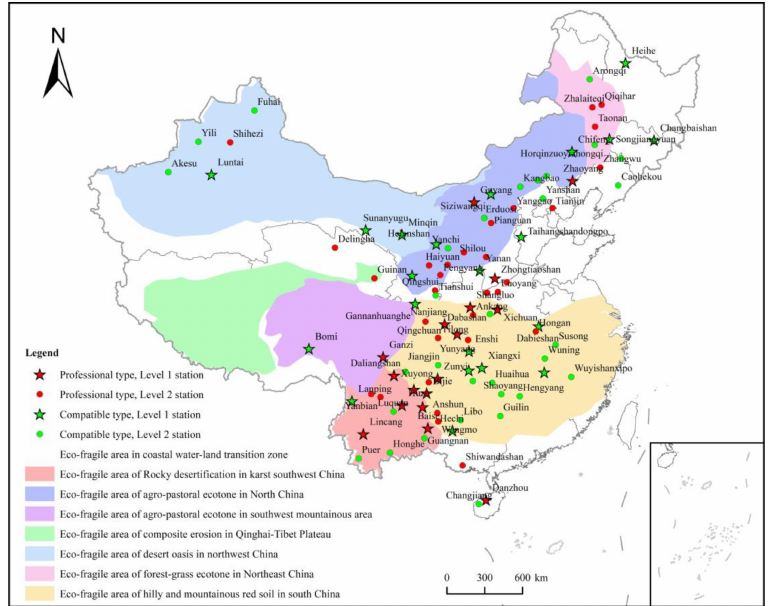
Figure 5. The layout of monitoring stations in the eco-fragile